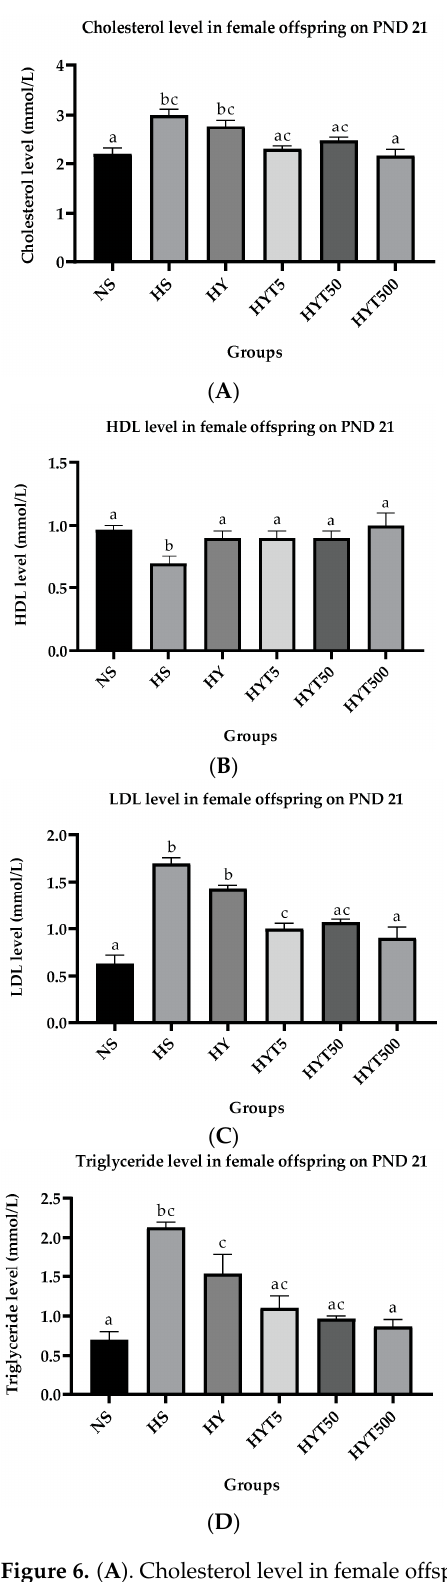
Figure 6. ( A ). Cholesterol level in female offspring on PND 21. ( B ). HDL level in female offspring on PND 21. ( C ). LDL level in female offspring on PND 21. ( D ). Triglycerides level in female offspring on PND 21. NS: normal chow and saline; HS: HFD and saline; HY: HFD and yoghurt; HYT5: HFD and 5 mg/kg of E. tapos yoghurt; HYT50: HFD and 50 mg/kg of E. tapos yoghurt; HYT500: HFD and 500 mg/kg of E. tapos yoghurt. Values are expressed as mean ± SEM. Different letters indicate a significant difference at p <